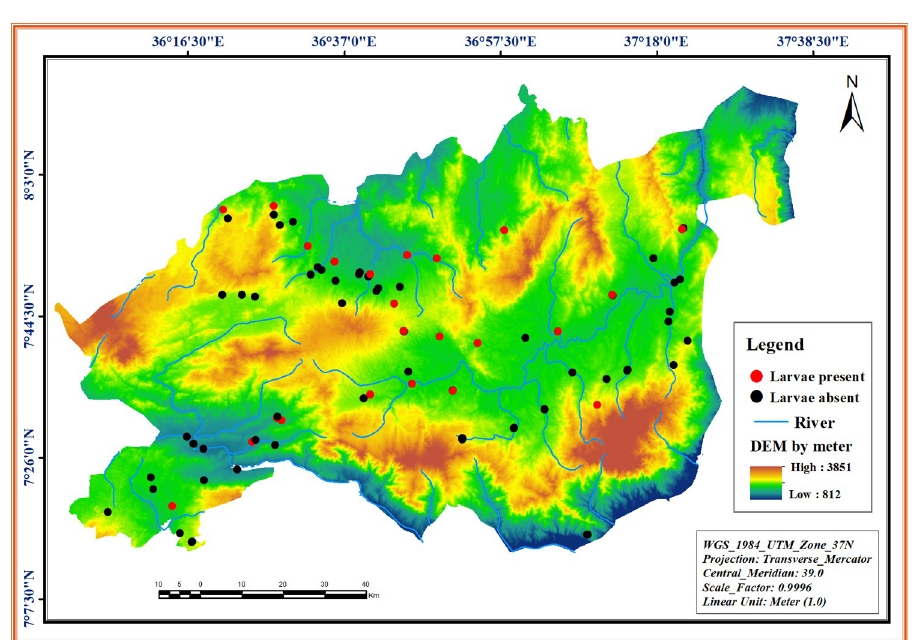
Fig 2. Digital Elevation Model (DEM) image of Omo Gibe river basin (southwest Ethiopia) indicating locations of the sampling sites.